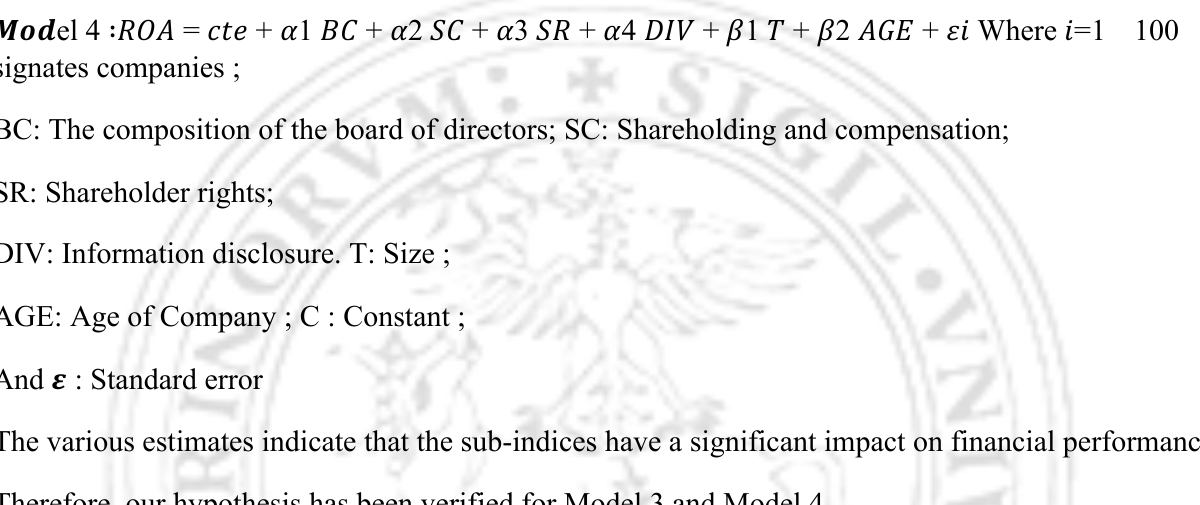
Table 4: Expressive study of Expression